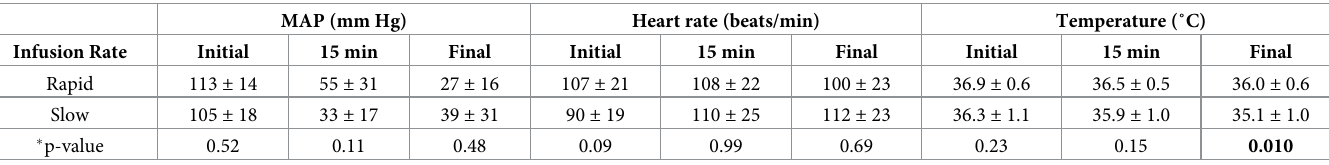
Table 2. Vital sign